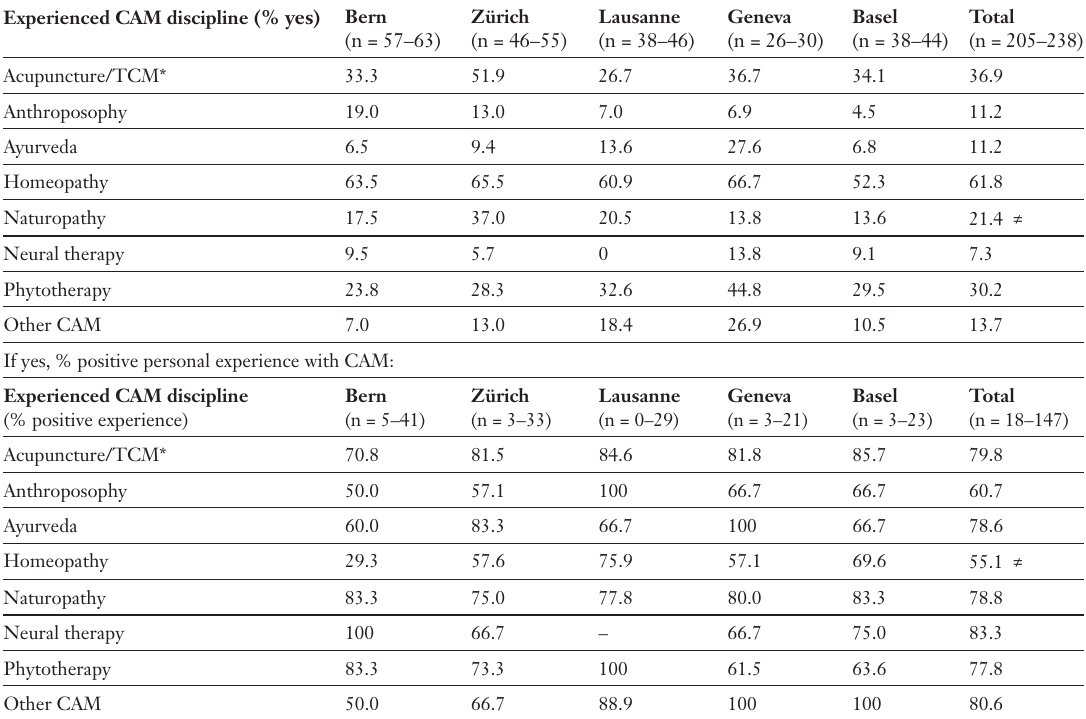
Students’ personal experience with CAM.